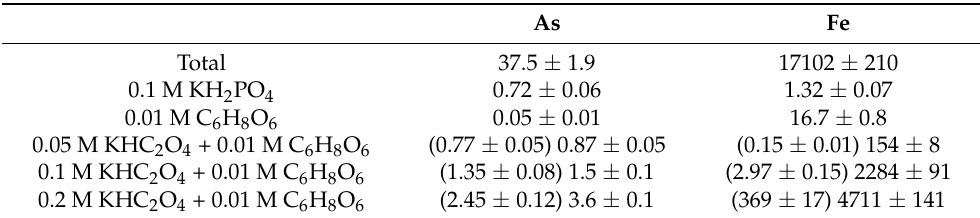
Table 1. Potentially bioavailable arsenic and iron contents (mg kg − 1 ) in the mixed soil collected at the site under investigation. Values are reported as means ( n = 3) ± SDs. As